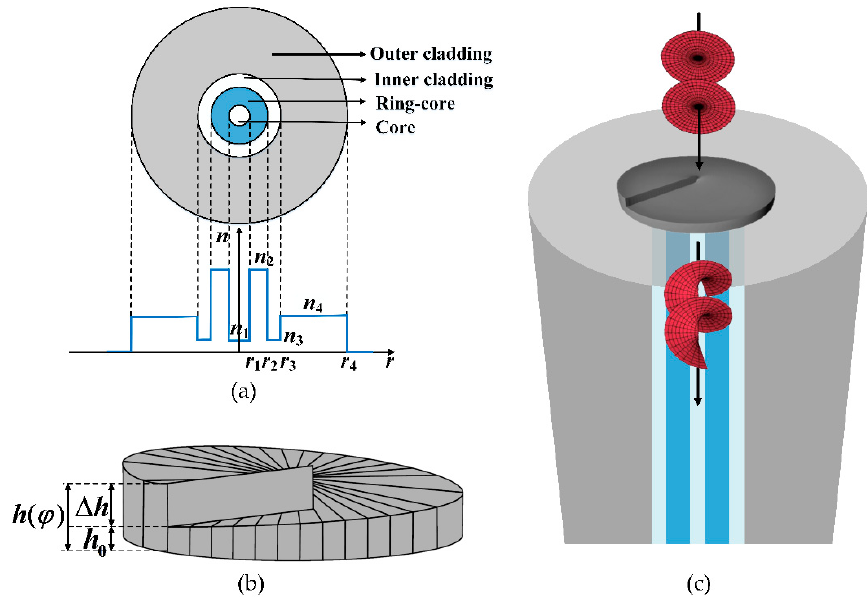
Figure 1. ( a ) Cross-section of the designed PbSe-doped RCF in schematic form; ( b ) Schematic of the construction of SPP; ( c ) Schematic of the OAM beam generated by the SPP at the end face of the fiber.